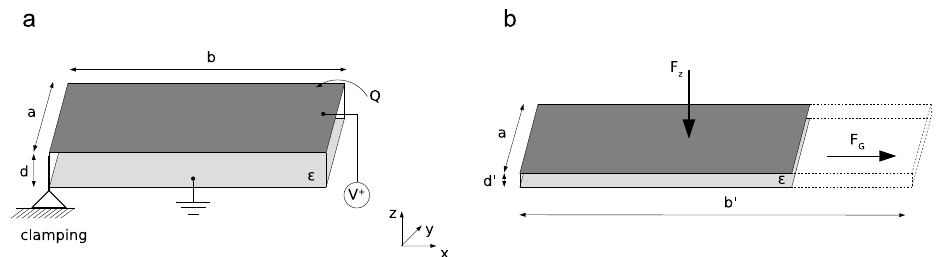
Figure 5. Actuator geometry based on a plate capacitor. ( a ) Initial undeformed state, clamped at the front, and ( b ) deformed state with the generated forces leading to an elongation of the actuator. The boundary conditions limit the deformation in the y